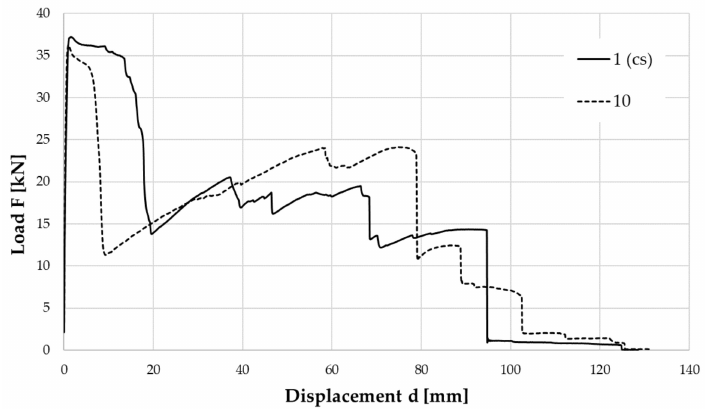
Figure 16. Tensile load-displacement response curves of samples 1 and 10, which were sandblasted with standard grit and corundum,